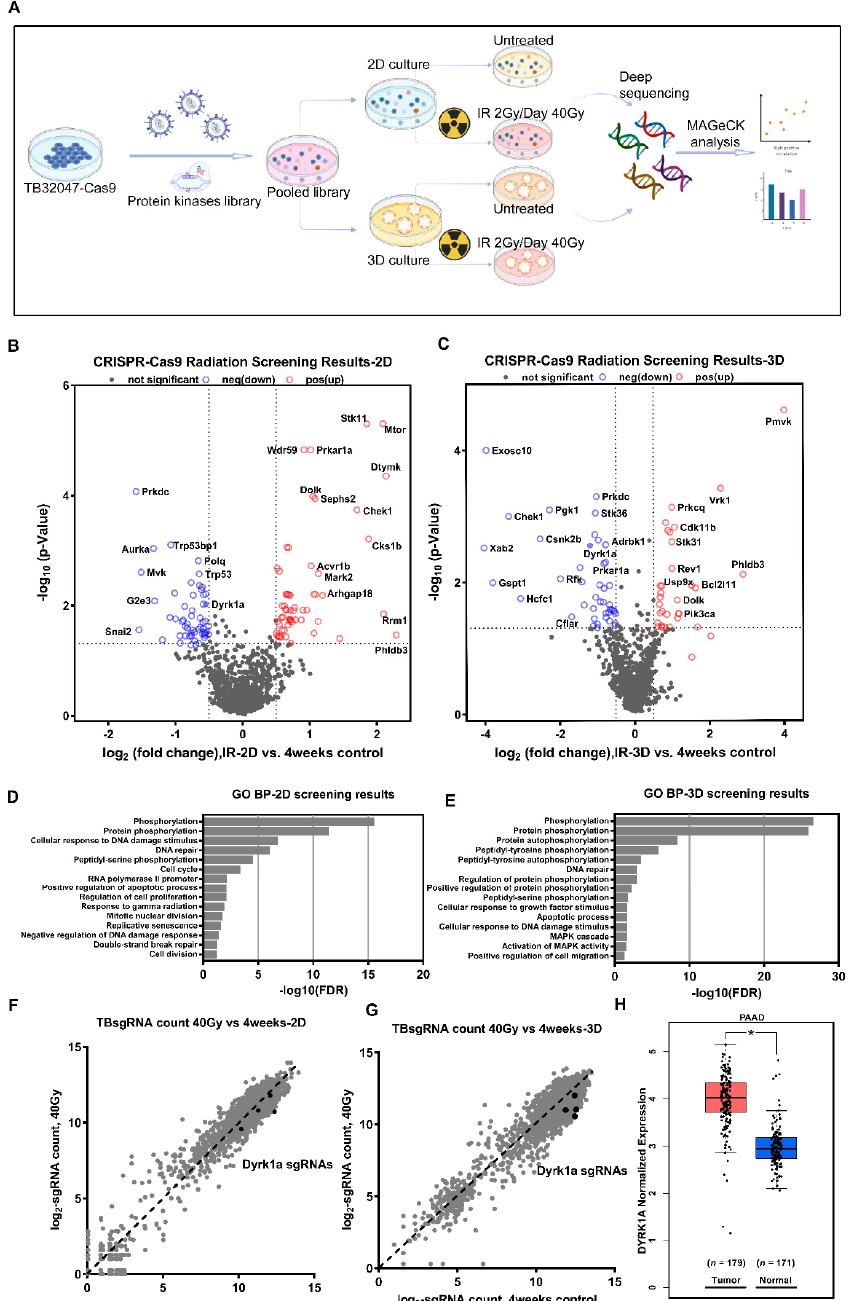
Figure 1. CRISPR-Cas9 loss-of-function screen identifies DYRK1A as a candidate for radiother- apy resistance. ( A ) Schematic diagram of the experimental procedure for CRISPR-Cas9 loss-of- function screen. ( B , C ) Volcano plots show the -log normalized p -value and log 2 fold change of 2D ( B ) and 3D ( C ) radiation screening results compared to the 4-week control, with significant genes in the negative selection highlighted in blue and positive selection highlighted in red, respectively. ( D , E ) Gene Ontology (GO) terms analyzed the biological processes enriched by 2D ( D ) and 3D ( E ) negative selection candidate genes. ( F , G ) Scatter plots show the log 2 -normalized counts changes of each sgRNA of DYRK1A in 2D ( F ) and 3D ( G ) screening. ( H ) Box plots of DYRK1A expression in pancreatic cancer and normal pancreatic tissues were analyzed using the TCGA (PAAD) and GTEx (pancreas) databases. *, p <